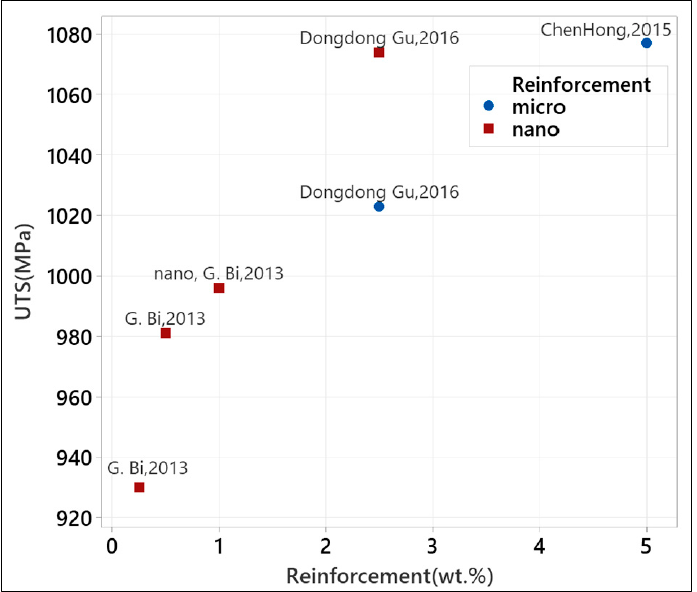
Figure 17. Effect of the TiC reinforcement concentration and particle size on the mechanical strength of the IN625 Composite (see Appendix A for data sources).